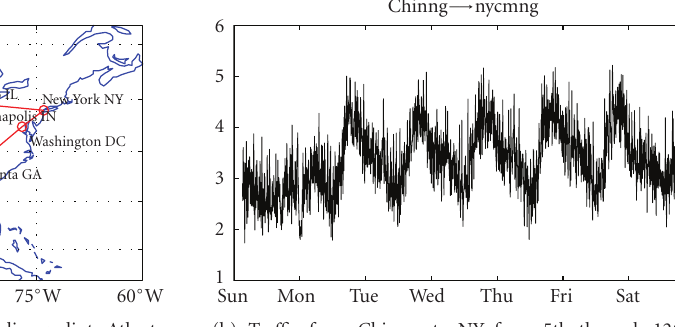
Figure 1: Abilene network and example tra ffi